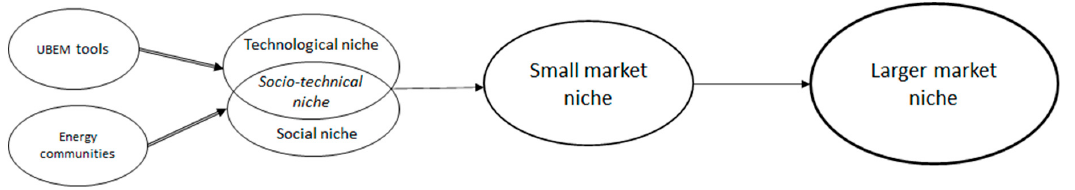
Figure 2. Positioning of research subject in niche development—adapted figure of Geels [65].